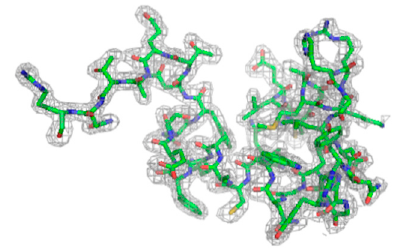
Figure 7. 2mF obs - DF calc electron density (contoured at 1 σ ) for residues 5–45 of the lysozyme for data collected at 2.4 kHz frame rate (dataset L12.4_5). collected at 2.4 kHz frame rate (dataset L12.4_5).